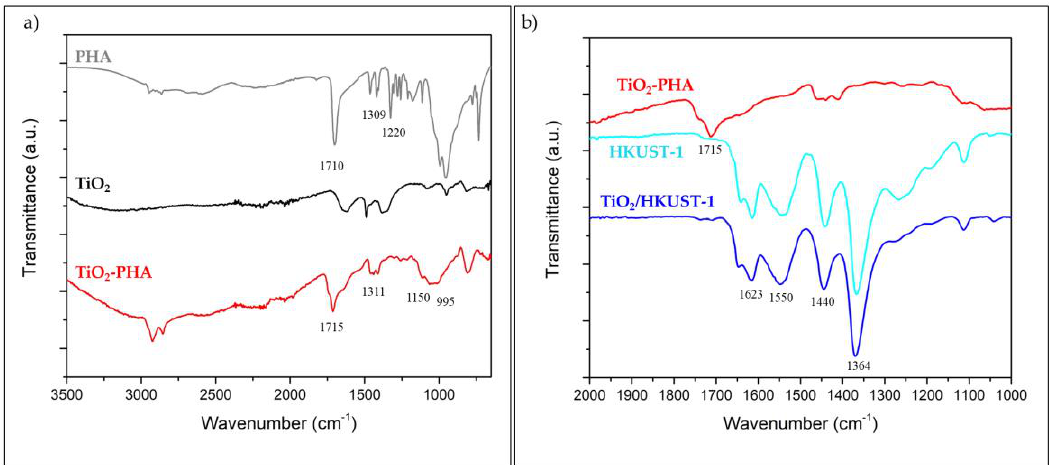
Figure 2. FTIR spectra of: ( a ) pristine PHA (top, gray line), RE TiO 2 NPs (black line) and TiO 2 -PHA (red line) and ( b ) TiO 2 -PHA (red line), HKUST-1 (sky blue line) and TiO 2 /HKUST-1 (blue line) in the 2000–1000 cm –1 range.